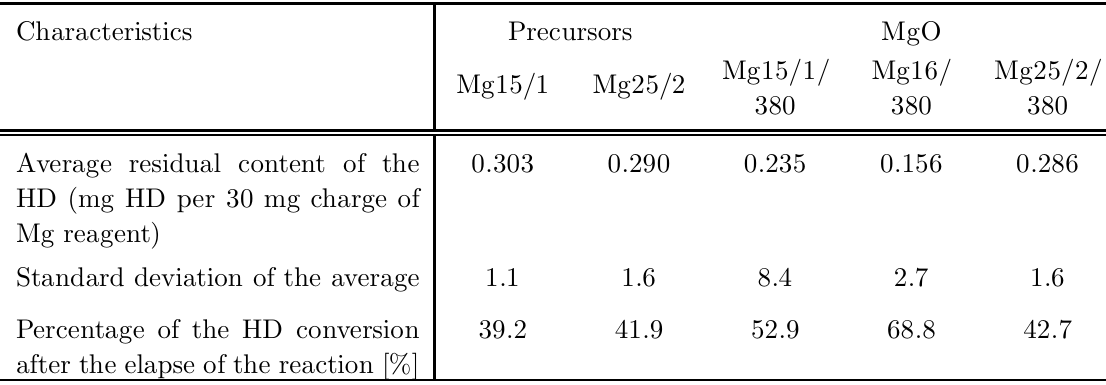
Table 4 Residual content of HD after reaction on the magnesium samples (reaction time 1 h, temperature 25 ¯ C, charge of the respective samples in the reaction 30 mg, 0.5 mg of HD dissolved in 0.1 ml of